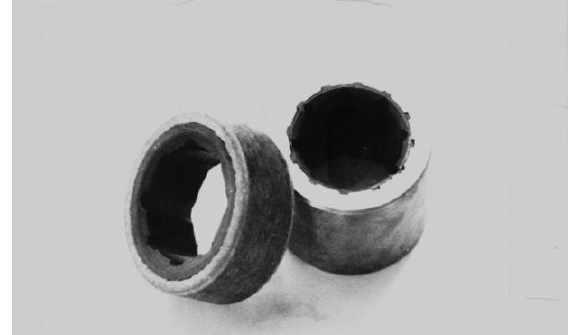
Fig.9 Restoration of the inner diameter of the radial bearing slip